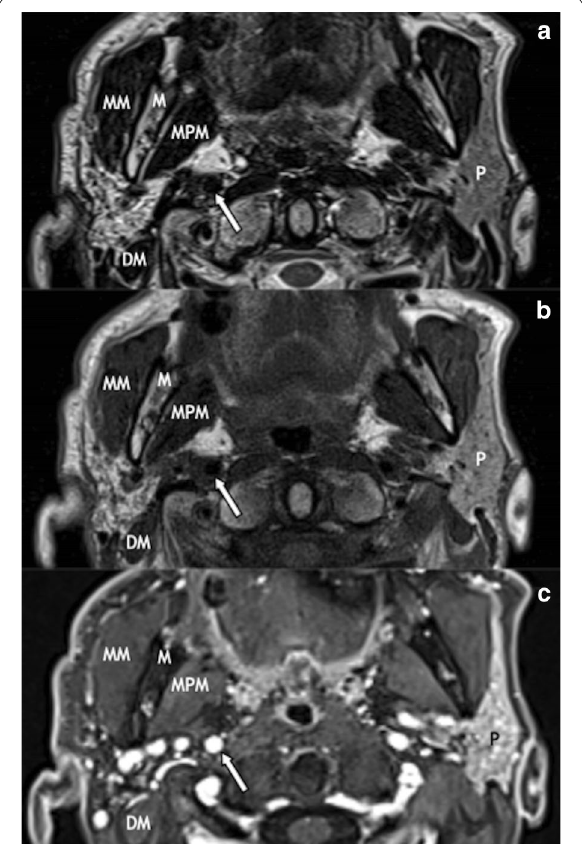
Fig. 8 Atrophy of the right parotid gland in a 73-year-old man 3 years after ChT/RT for a carcinoma of the right inferior alveolar crest. MR images show a right parotid gland smaller than the contralateral, with high signal on axial T2-weighted ( a ), high signal on T1-weighted ( b ), and low signal on post-contrast 3D GRE fat-sat T1-weighted ( c ) images, due to extensive fatty infiltration of the parenchyma. P, parotid gland; M, mandible; MM, masseter muscle; MPM, medial pterygoid muscle; DM, digastric muscle; internal carotid artery (arrow)